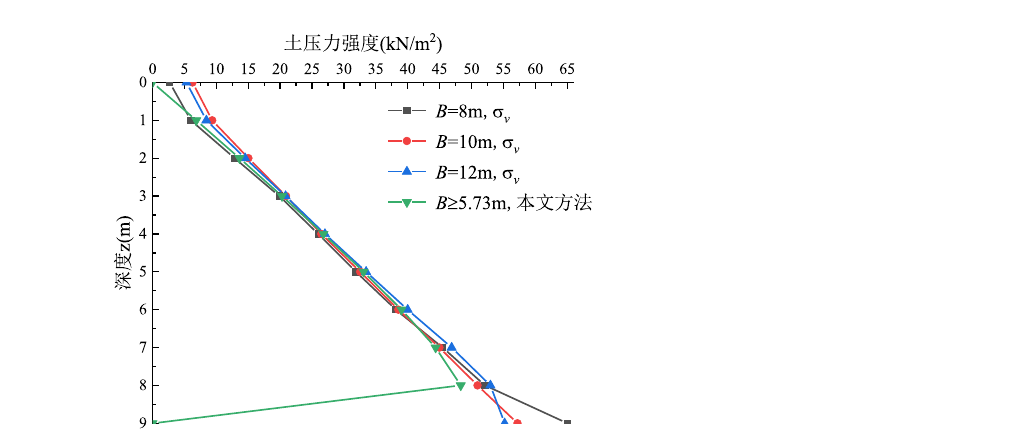
Figure 11. The comparison of calculation results when B ≥ H tan